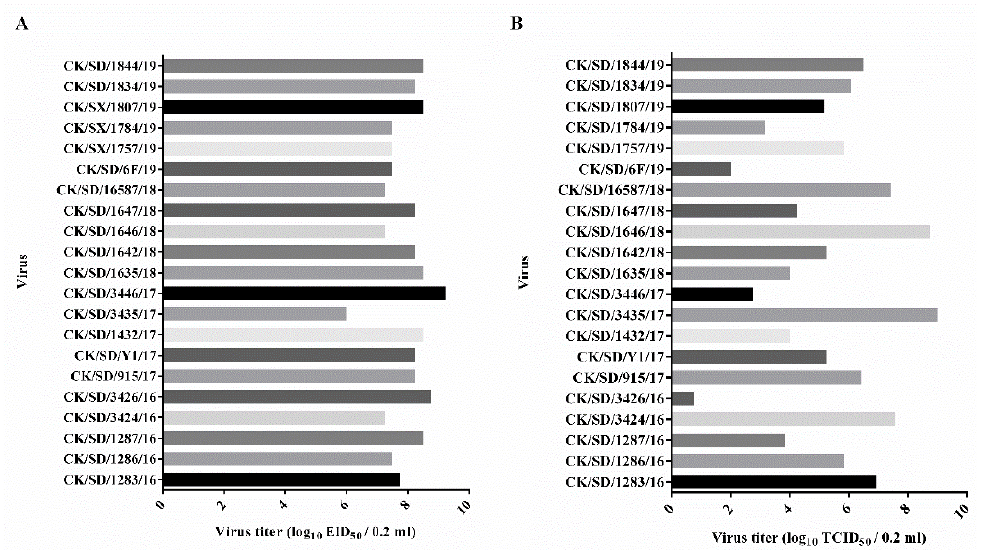
Figure 1. Viral replication capacities in embryonated chicken eggs and MDCK cells. Allantoic fluid containing the H9N2 viruses were determined for EID 50 in 10-day-old embryonated chicken eggs ( A ) and TCID 50 in MDCK cells ( B ). Virus titers were given in units of log 10 EID 50 or log 10 TCID 50 per 0.2 mL.